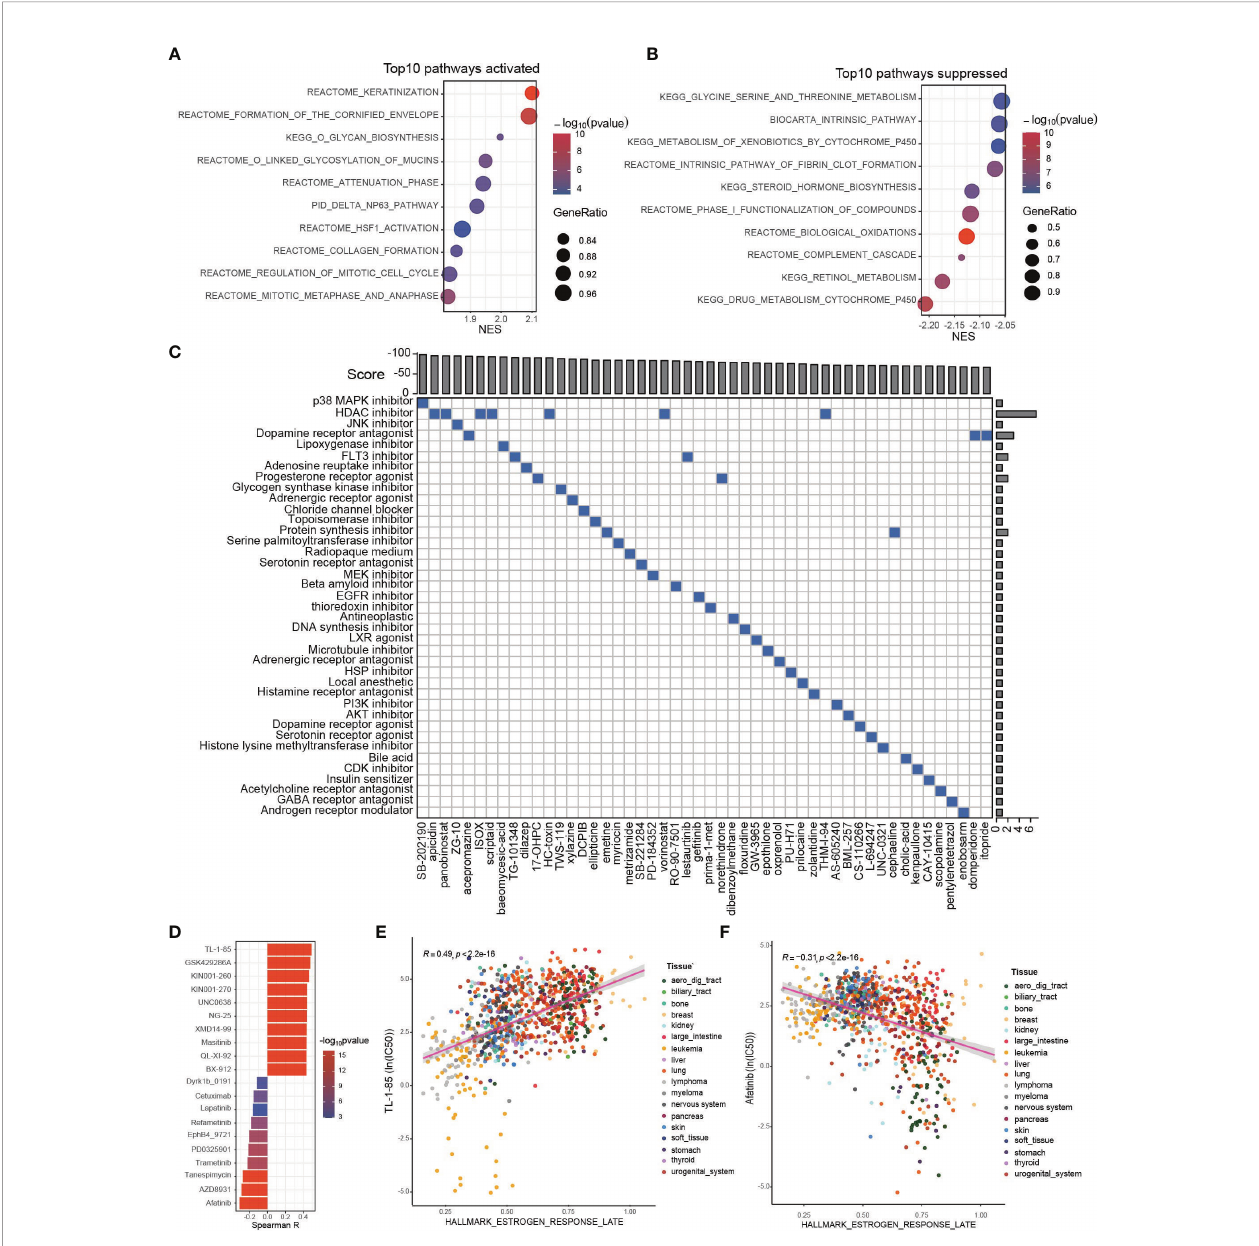
FIGURE 6 | Potential therapeutic targets and applicable drugs according to ESRS or estrogen response. (A, B) GSEA was performed between the ESRS_high and ESRS_low groups. The bar plots show the top 10 upregulated or downregulated pathways in the ESRS_high group. (C) The differentially expressed genes were submitted to CMap mode-of-action (MoA) analysis, and the results showed 39 mechanisms of action shared by the top 50 compounds potentially applicable for ESRS_high patients. (D) The correlation between GSVA score of “ Estrogen response late ” and ln(IC50) of drugs in cancer cell lines. (E, F) Scatter plots showing the correlation between the GSVA score of “ Estrogen response late ” and the ln(IC50) of TL-1-85 or afatinib in cancer cell lines. The color of the dot represents the histologic origin of the cancer cell